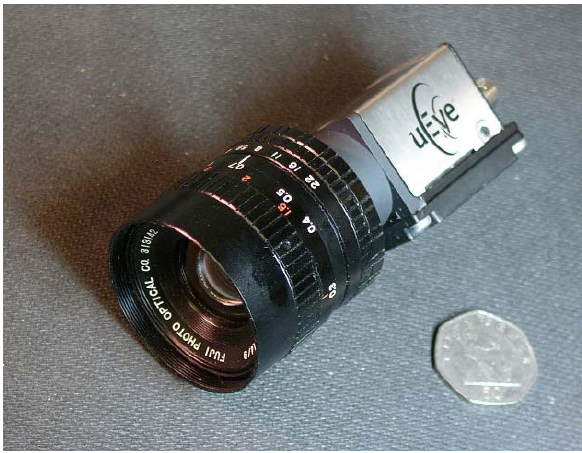
Figure 2. Miniature uEye camera fitted with Fujinon 9mm C- mount lens. The 50p coin shows the relative